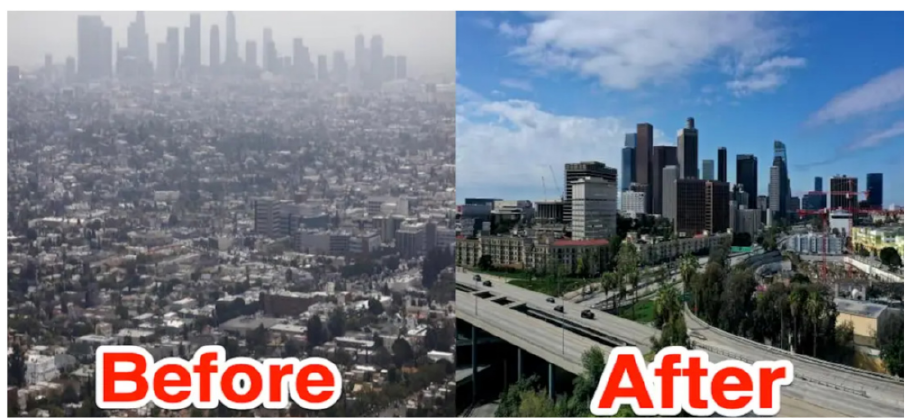
Figure 1. Before and after photos show how stay-at-home orders during COVID-19 helped Los Angeles significantly reduce its notorious smog [1]. Displaying clear-cut differences in smog levels.